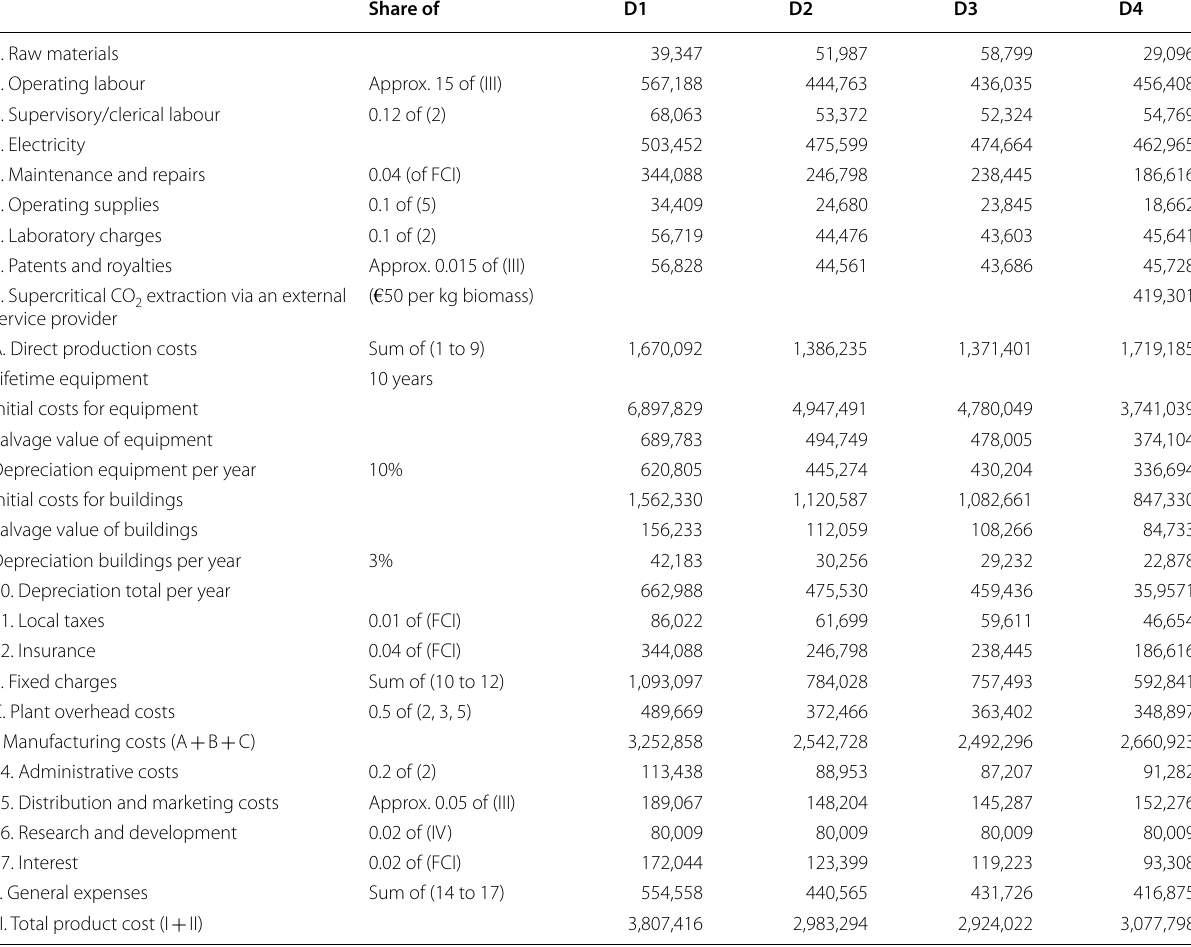
Table 6 Direct production costs (A), Fixed charges (B) and plant overhead costs (C), manufacturing costs (I, A expenses (II) and total production costs (I different downstream scenarios, D1, D2, D3, and D4